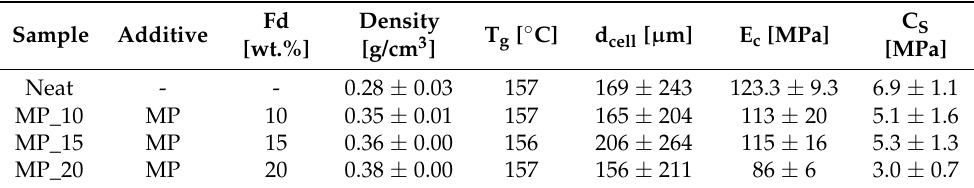
Table 5. Specimens of MP fill study incl. neat comparison specimens: filler degree (Fd), density, T g , derived from DMA (Peak tan δ )., average foam cell diameter (d cell ), compression modulus (E c ), compressive strength (C s ).